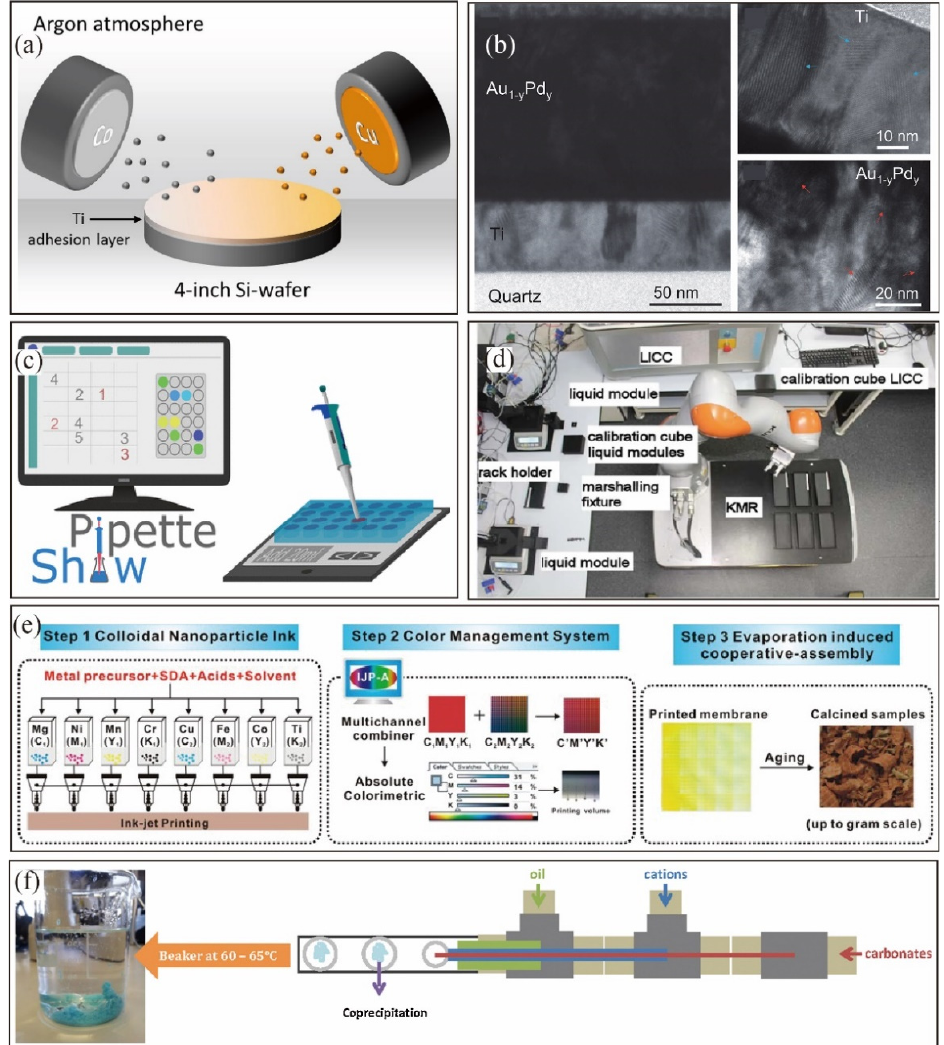
Figure 5. High-throughput synthesis of catalyst candidates. ( a ) Schematic diagram showing the preparation of catalysts by sputtering deposition. Reprinted with permission from Ref. [29]. Copy- right 2016, Elsevier. ( b ) Bright-field TEM image of the cross section of a thin multilayer film prepared by electron beam deposition. Reprinted with permission from Ref. [90]. Copyright 2015, The Royal Society of Chemistry. ( c ) An automatic platform that can generate efficient pipetting-to-microplate workplans and support their reliable execution with visual guidance. Reprinted with permission from Ref. [92]. Copyright 2022, American Chemical Society. ( d ) Operations performed autonomously in a combined liquid handling/capping station by mobile robots. Reprinted with permission from Ref. [93]. Copyright 2020, Springer Nature. ( e ) Synthesis of multi-component mesoporous metal oxides using inkjet printing. Reprinted with permission from Ref. [82]. Copyright 2012, American Chemical Society. ( f ) Controlled preparation of catalysts by flow chemistry in microfluidic channels. Reprinted with permission from Ref. [99]. Copyright 2016,